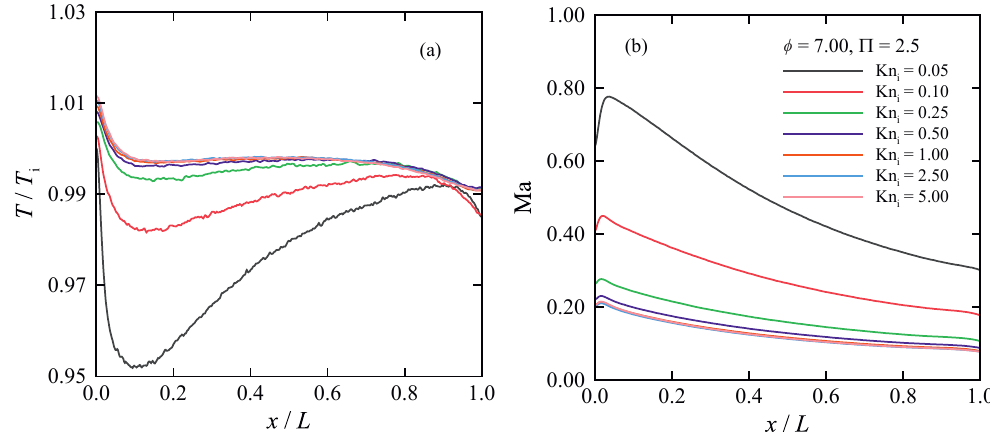
Figure 6. The effect of rarefaction on the profiles of ( a ) gas temperature and ( b ) Mach number along the microchannel centreline ( φ = 7.00 and Π = 2.5). The inlet temperature ( T i ) is used to non-dimensionalise the predicted temperatures.